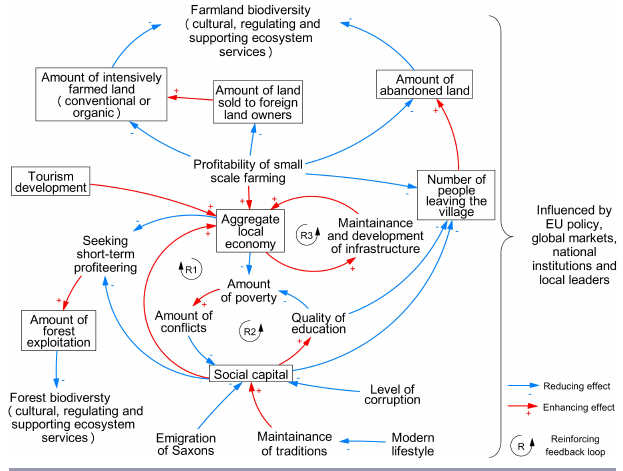
Fig. 5. Causal loop diagram summarizing the dynamics of the regional social-ecological system. Red arrows, enhancing effects; blue arrows, reducing effects. Variables in boxes were considered by local stakeholders to vary spatially in response to locally variable socioeconomic or ecological